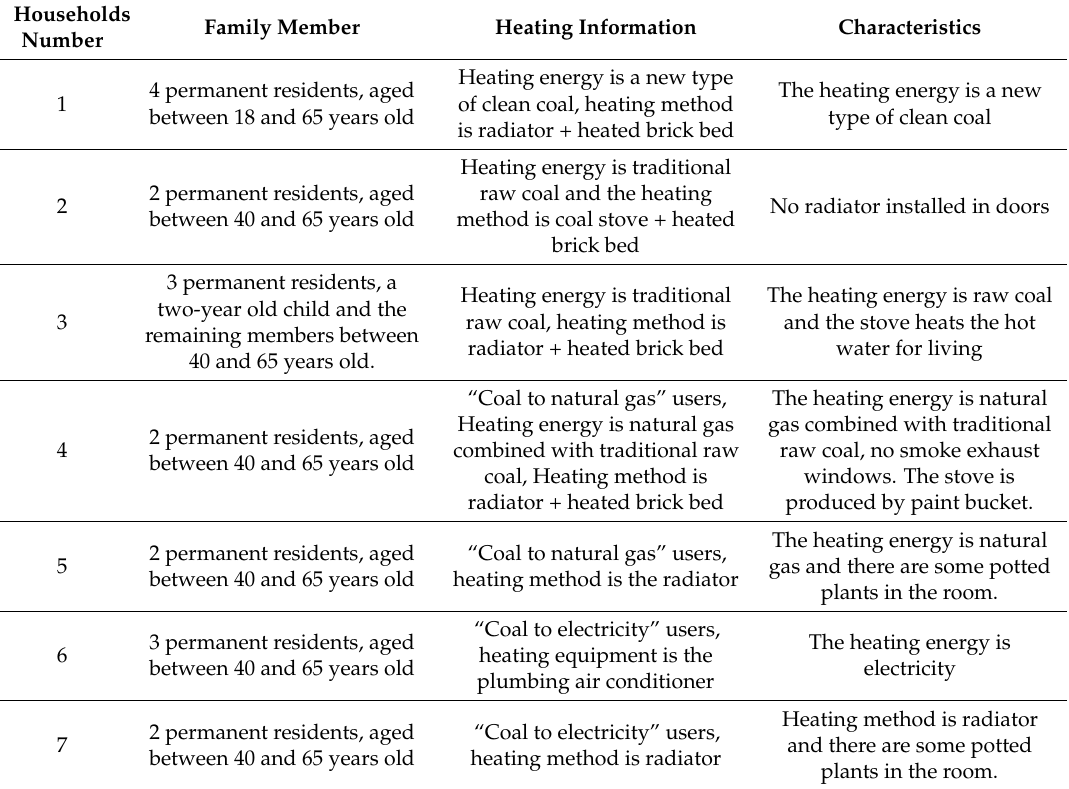
Table 1. Households information statistics in rural region of